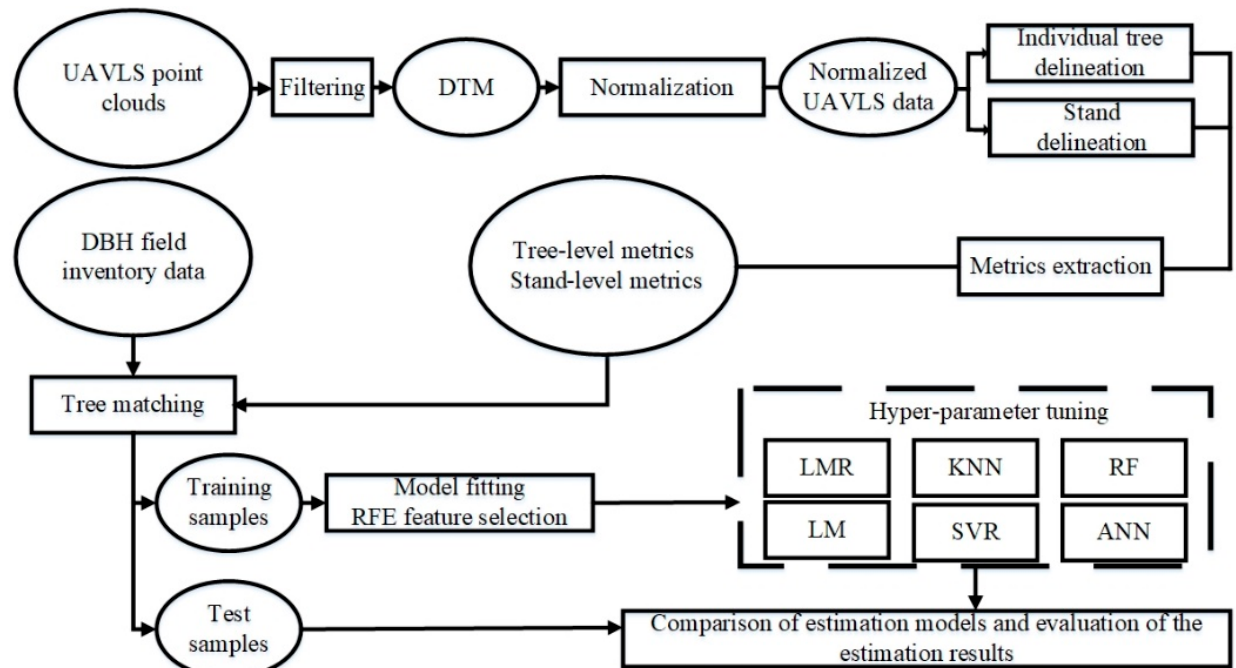
Figure 2. An overview of the workflow for DBH estimation by different methods using UAVLS data.